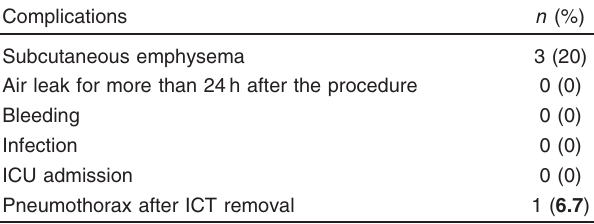
Table 5 Complications in the study